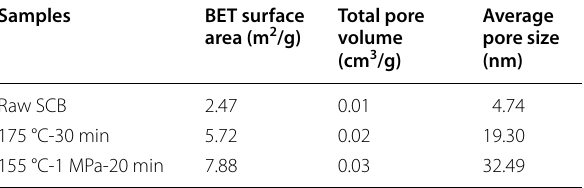
Fig. 4. In the pretreatment process, two factors deter-